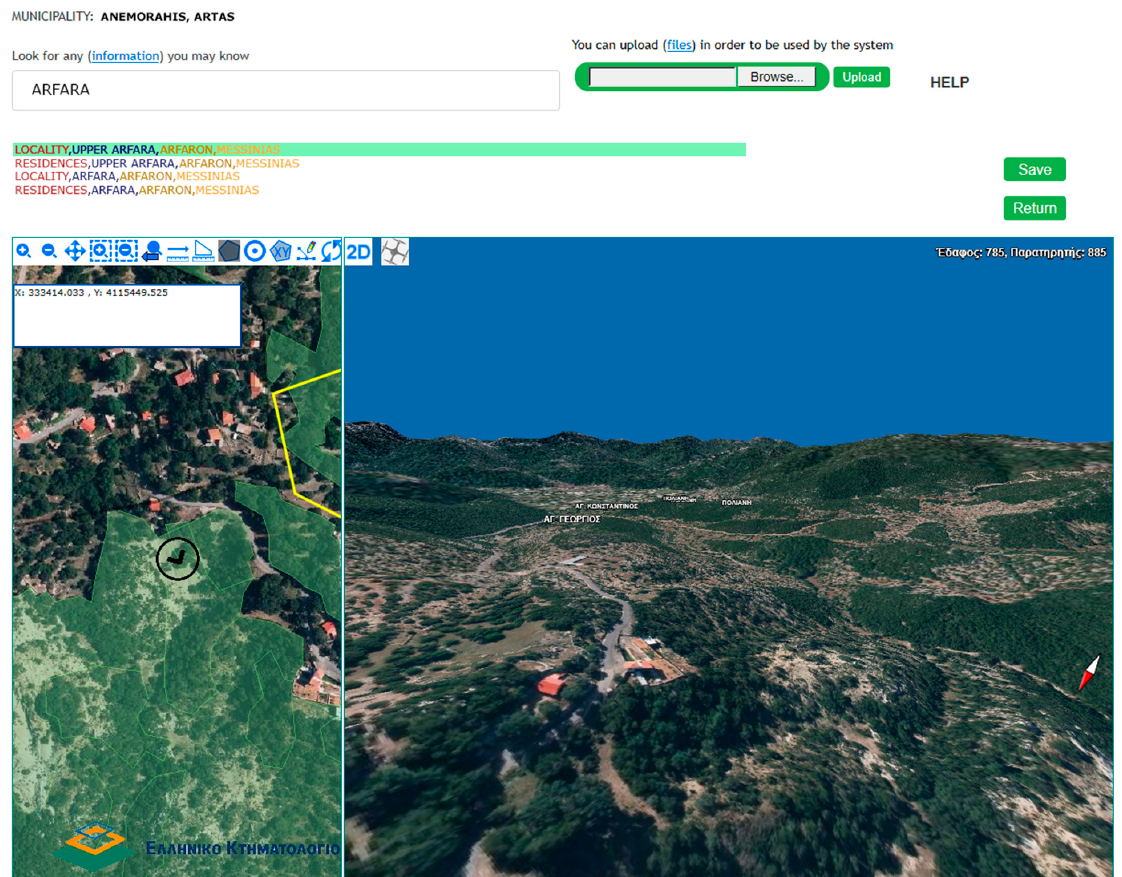
Figure 7. Both 2D and 3D representations of the area in order to help the user locate the property. User can navigate in both windows.